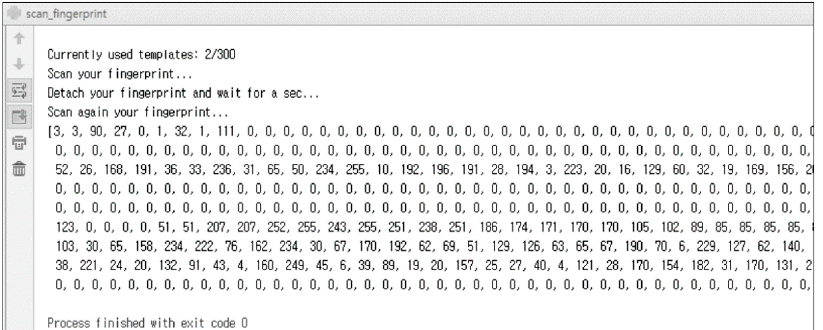
Figure 11. Scanning Fingerprint Module.